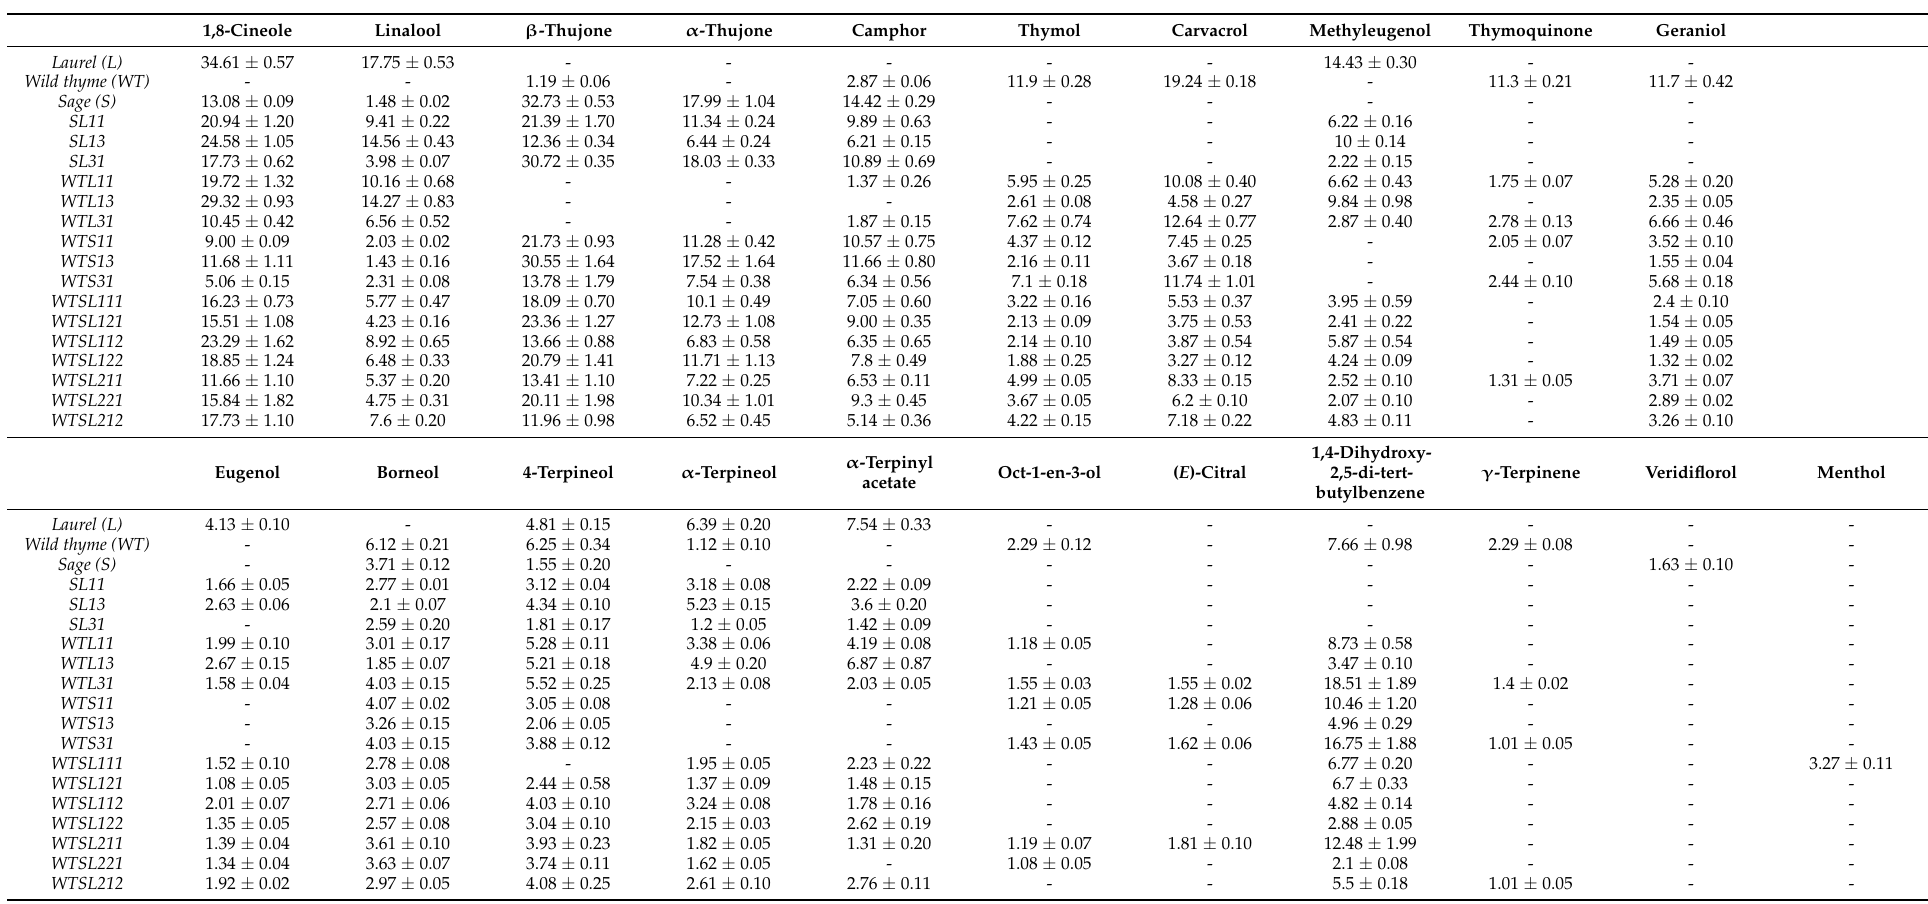
Table 4. The headspace chemical composition of sage, wild thyme and laurel herbal extract and their mixtures (Table 1) as determined by HS-SPME/GC-MS analysis. 1,8-Cineole Linalool β -Thujone α -Thujone Camphor Thymol Carvacrol Methyleugenol Thymoquinone Geraniol Laurel